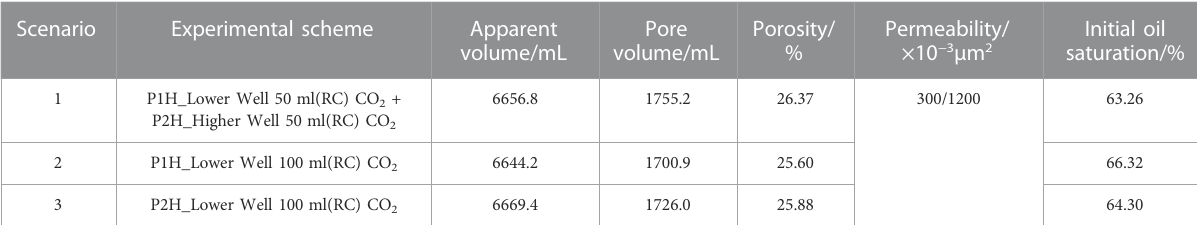
TABLE 4 Basic parameters of 3D physical